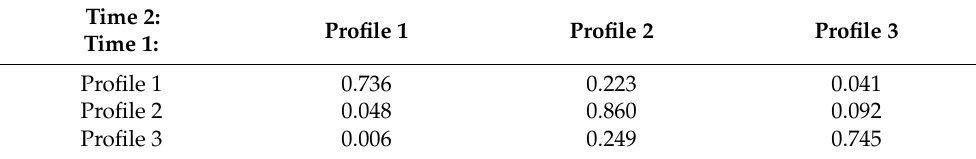
Table A4. Transition